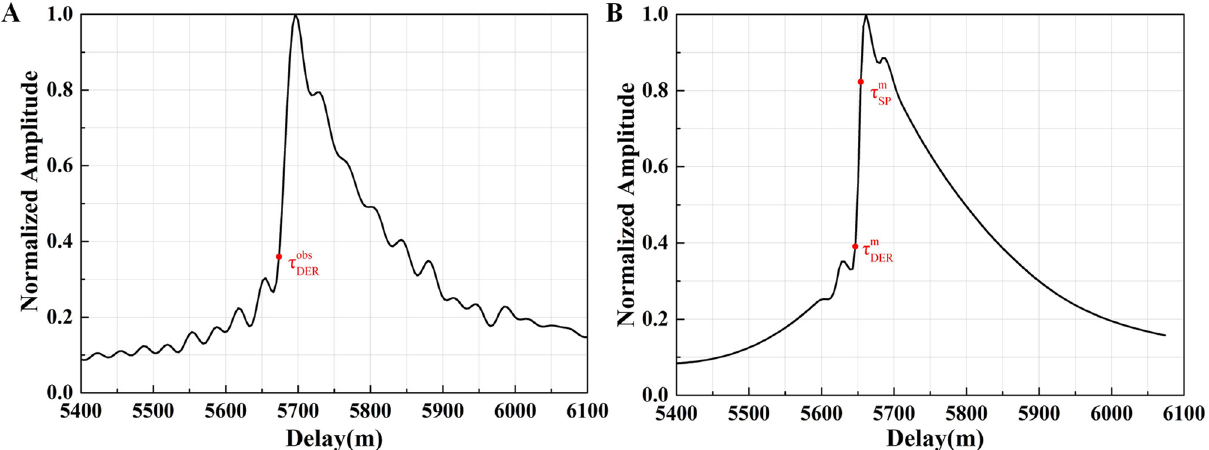
Figure 2. Examples of measured and simulated power waveforms. ( A ) Normalized measured power waveform processed from the IF data. The τ obs is the maximum point of the first derivative. ( B ) Normalized simulated power waveform generated based on the Z-V model. The τ m is the maximum point of the first derivative. The τ m sp is the nominal SP calculated based on the WGS-84 reference ellipsoid.